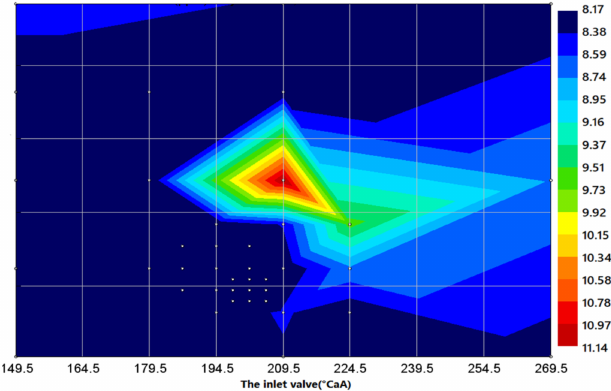
Figure 11. NO x emission of B0 under 75% load